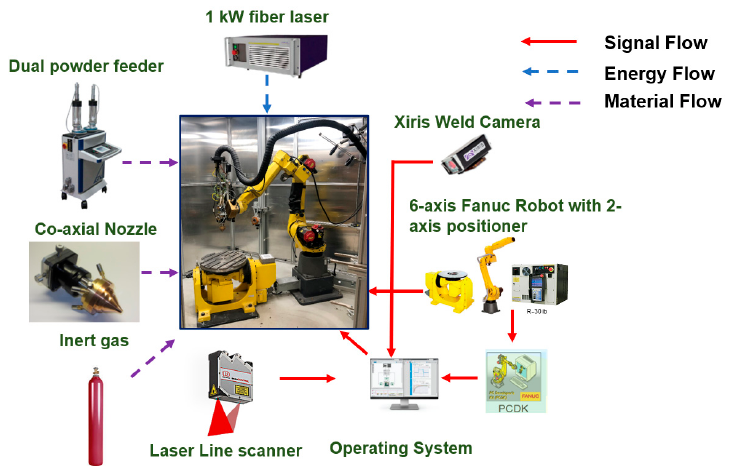
Figure 2. Schematic of LDED-PF system used for deposition.